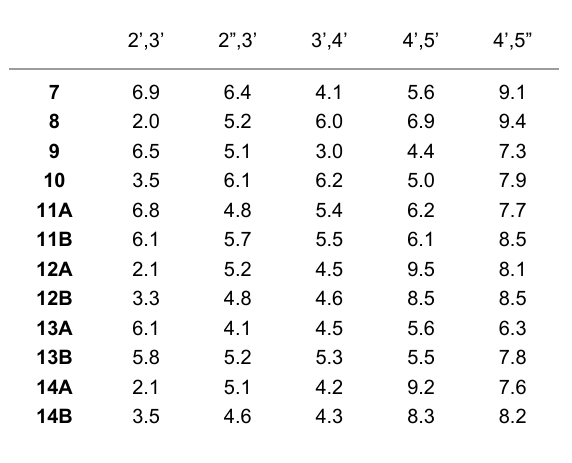
Table 2: The 3 J HH of the pyrrolidine-ring protons used in the con- formational